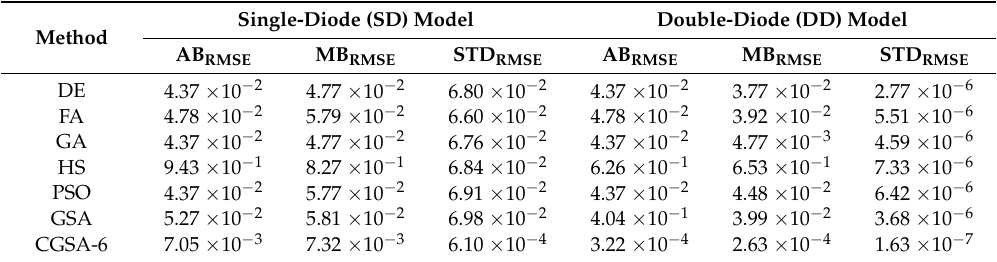
Table 10. Minimization results for the SD and DD models by applying DE, FA, GA, HS, PSO, GSA and CGSA-6. Each set of results consider 30 individual runs (with t = 4000 iterations each and N p = 100 search agents). Note that the best outcomes for each of the simulated solar cell models are